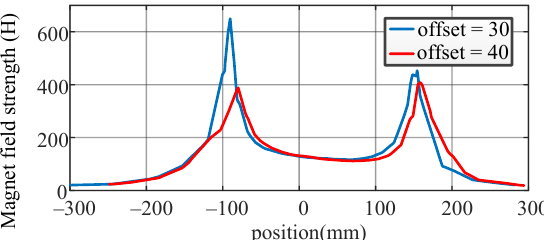
Figure 33. Magnetic field strength curves with the conventional structure and larger offsets of the